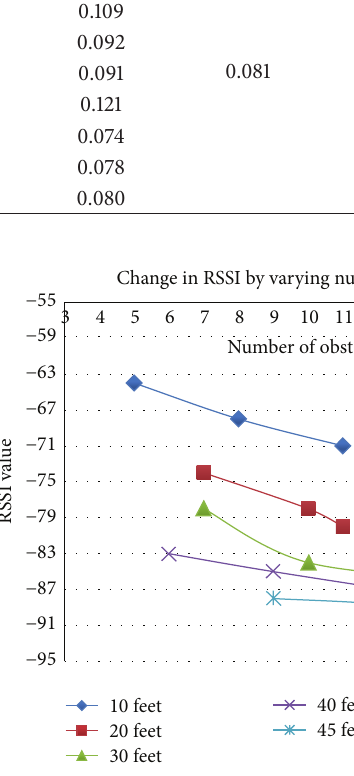
Figure 2: Effect on RSSI value by increasing number of obstacles.